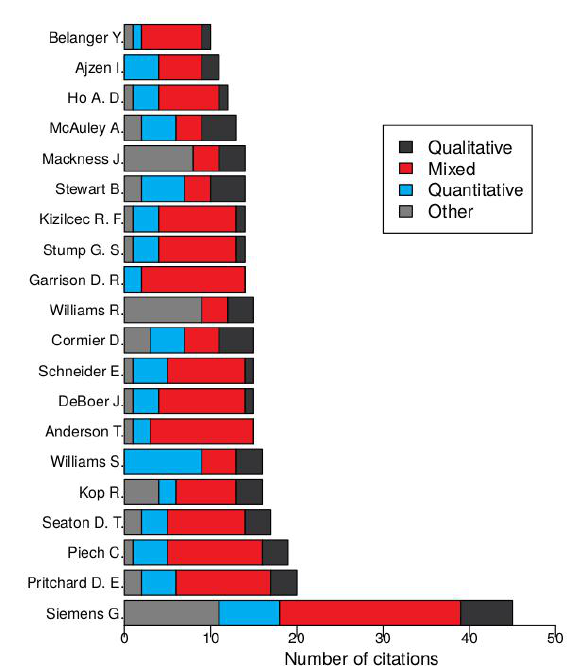
Figure 3 . Phase 2 most cited authors